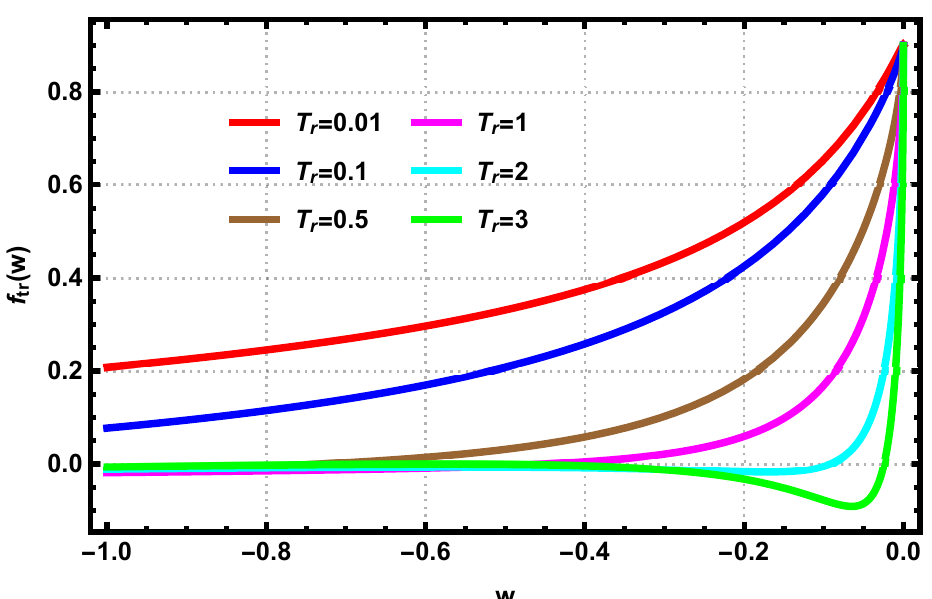
Figure 14. The characteristics of trapped ion distribution function for different T r keeping δ = 10 and ψ = 0.01 as constants. The emergence of saddle point after T r crosses the threshold, T r = 1, denotes the occurrence of forbidden gap in the width-amplitude